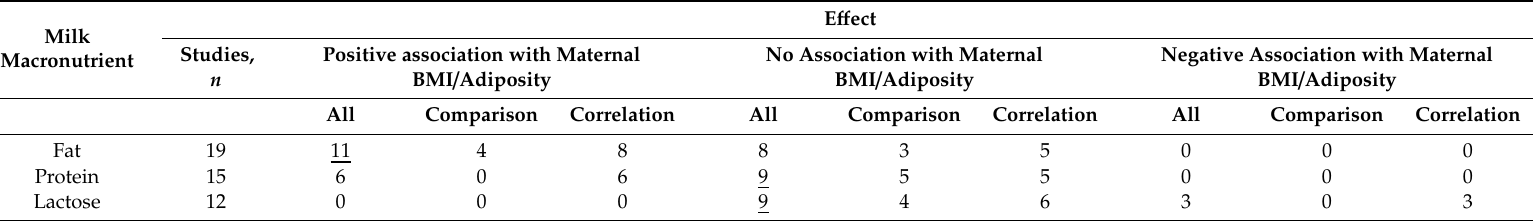
Table 3. Summary results of qualitative synthesis across all stages of lactation for studies reporting both comparison and correlation analysis 1